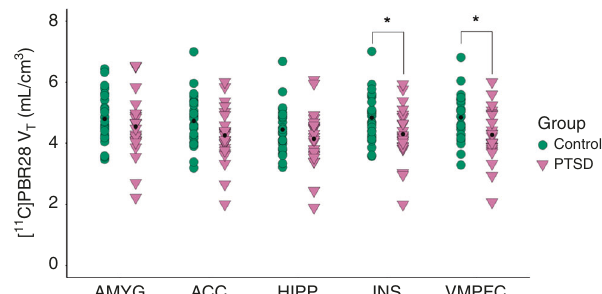
(Supplementary Fig. 1). Interpersonal trauma (sexual, physical, childhood) was more prevalent in the PTSD compared to control group.